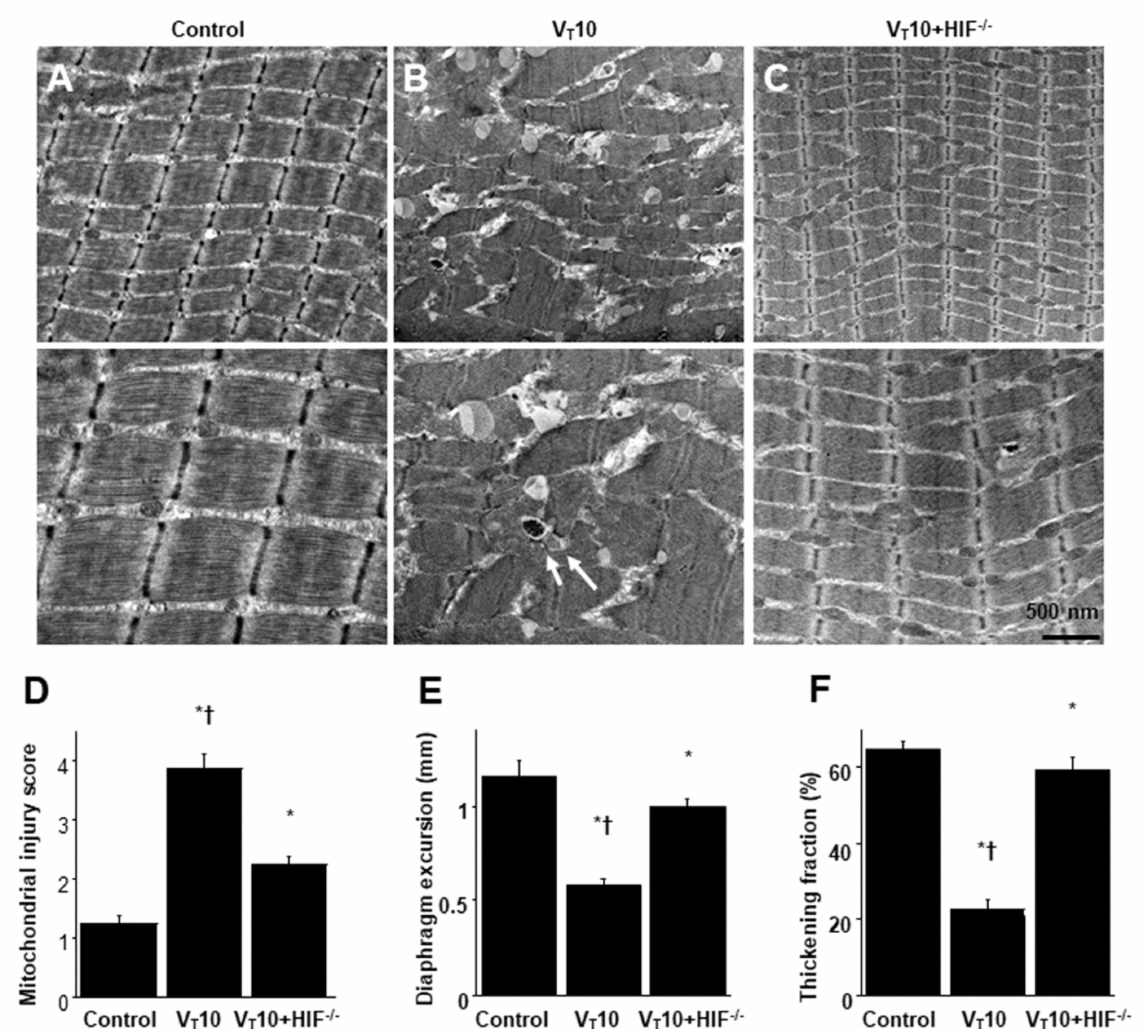
Figure 6. Reduction of endotoxin-exacerbated mechanical ventilation-induced diaphragm and mitochondrial injury in HIF-1 α deficient mice. ( A – D ) Representative micrographs of the longitudinal sections of diaphragm ( × 20,000: upper panel; × 40,000: lower panel) were from the diaphragms of non-ventilated control mice and mice ventilated at a tidal volume of 10 mL/kg for 8 h with LPS administration (n = 3 per group). Mitochondrial swelling with coexisting vacuole formation, loss of cristae, and autophagosomes containing heterogeneous cargo are identified by arrows. Mitochondrial swelling with concurrent loss of cristae and autophagosomes containing heterogeneous cargo are identified by arrows. ( E , F ) Excursion and thickness variation of diaphragm. * p < 0.05 versus the non-ventilated control mice with LPS treatment; † p < 0.05 versus HIF-1 α -deficient mice. Scale bars represent 500